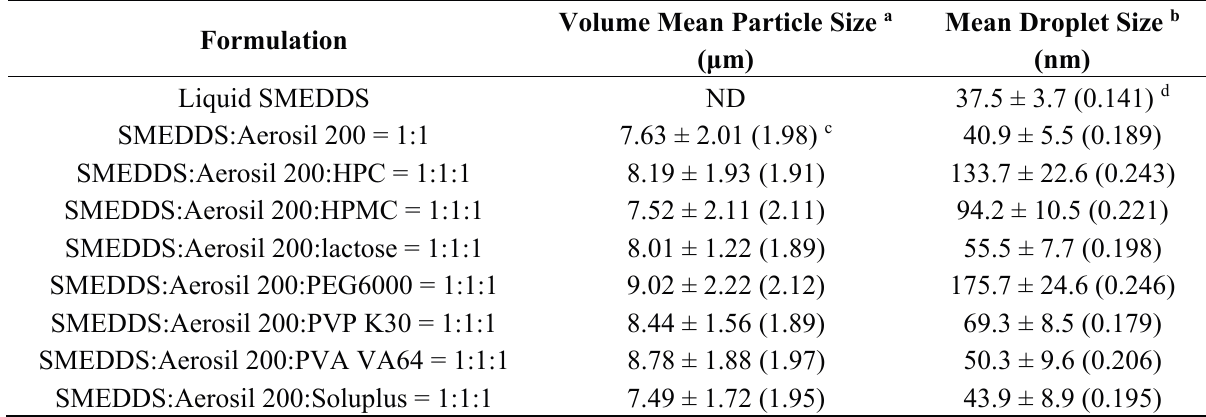
Table 1. Formulation and particle size of dutasteride-loaded solid-supersaturatable